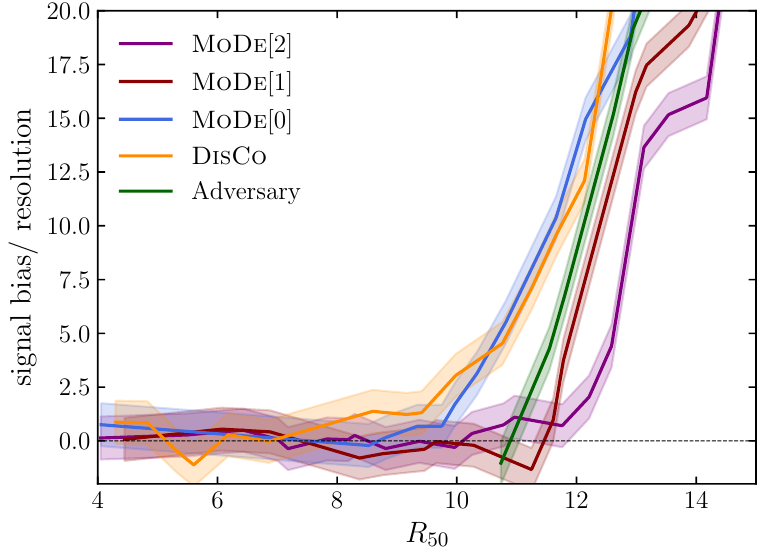
Figure 8 . Signal bias relative to resolution, which is roughly the square root of the background in the signal region, versus background-rejection power. The flexibility beyond simple decorrelation provided by MoDe [1] and MoDe [2] result in improved performance, i.e. larger rejection